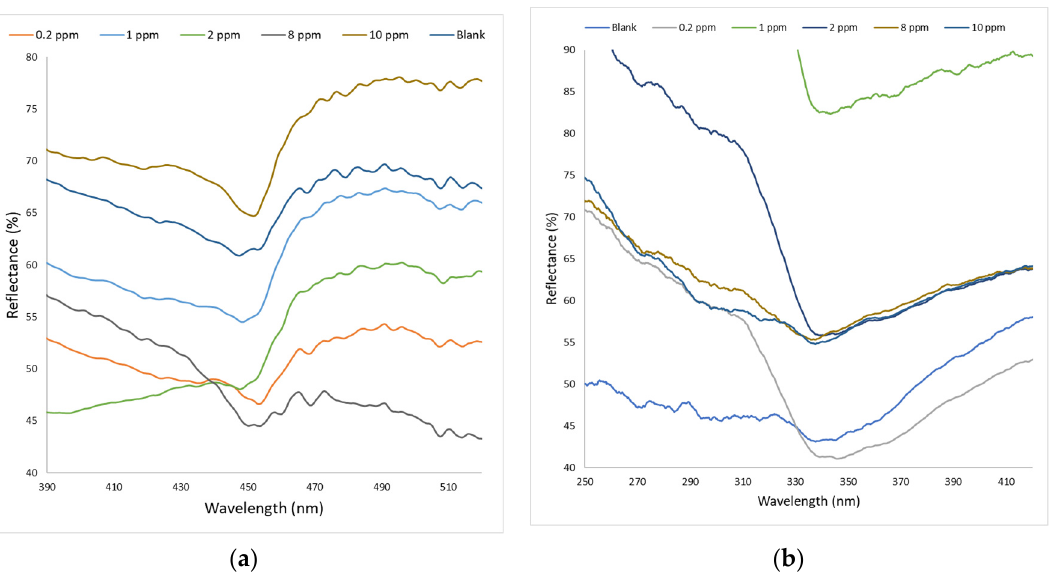
Figure 8. LSPR spectra for the detection of chlorophyll at different concentrations using ( a ) AgNPs and ( b ) a AgNP–CQD composite.